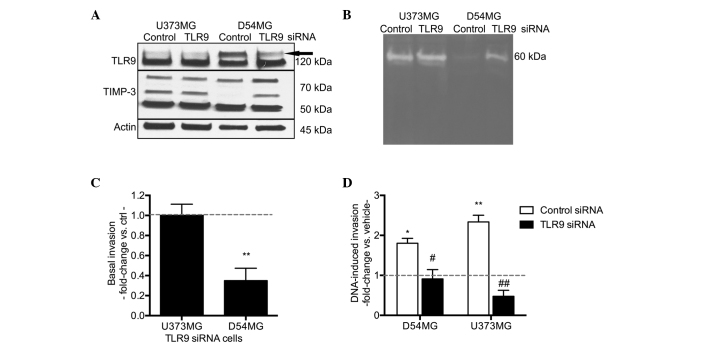
Characterization of the control and TLR9 siRNA cells in normoxia. (A) Expression of TLR9 (indicated by the arrow) and TIMP-3 proteins in the indicated cells. Actin bands were used to indicate equal loading. (B) Zymograms of the supernatants of the indicated cells cultured in normoxia. (C) The basal invasive capacity of the indicated TLR9 siRNA cells. Data are presented as the percentage of basal invasion of the corresponding control siRNA cells in normoxia (mean ± SEM; n=9–13) **P<0.01, vs. the corresponding control siRNA cells (indicated by the dotted line). (D) TLR9-ligand (G-quadruplex-DNA) induced invasion in control and TLR9 siRNA cells. Data are presented as a fold-increase of invasion, as compared with the vehicle treatment (indicated by the dotted line; mean ± SEM; n=3–9) *P<0.05 and **P<0.01, vs. the corresponding vehicle-treatment; and #P<0.05 and ##P<0.01, vs. the corresponding control siRNA cells. TLR9, toll-like receptor-9; TIMP-3, tissue inhibitor of matrix metalloproteinases.